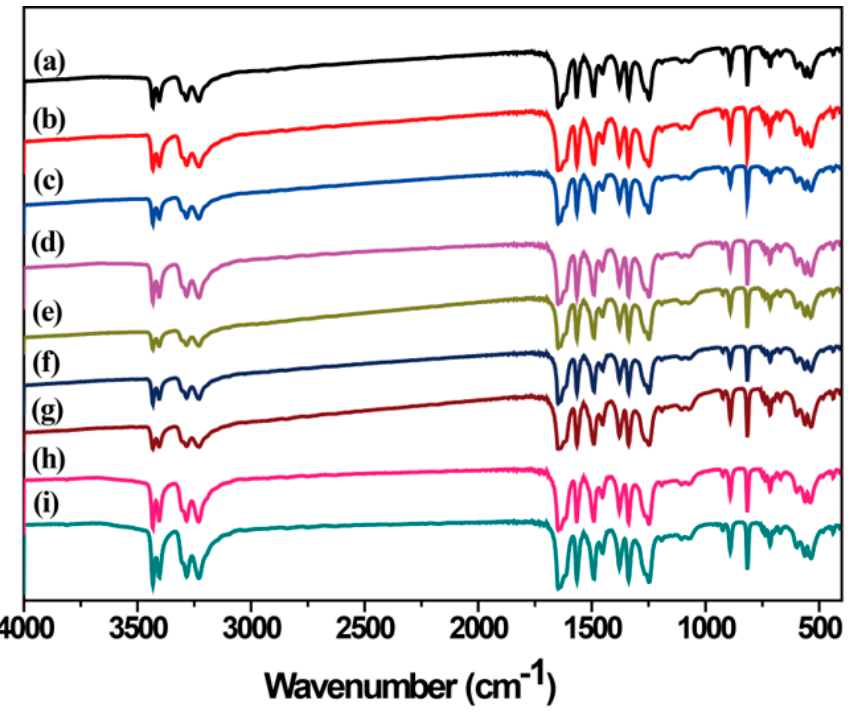
Figure 4. Fourier transform infrared (FTIR) spectra of LLM-105 crystals obtained from different antisolvents. ( a ) Water, ( b ) methanol, ( c ) acetic acid, ( d ) nitromethane, ( e ) ethyl acetate, ( f ) ethanol, ( g ) methylene chloride, ( h ) o-dichlorobenzene, and ( i ) toluene.